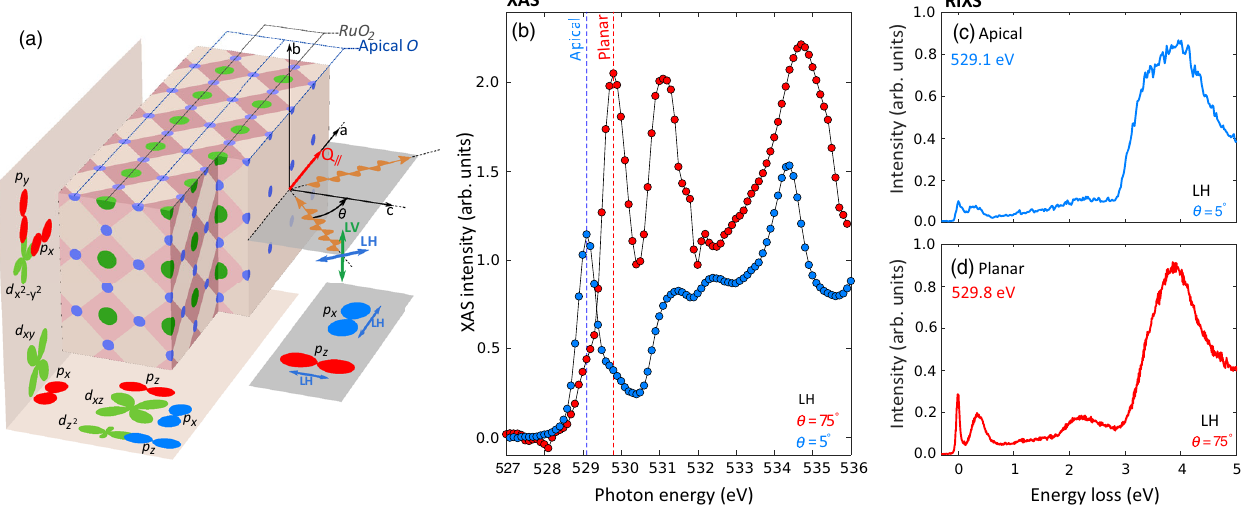
FIG. 1. (a) RIXS geometry with respect to the crystal lattice of Ca 2 RuO 4 is displayed schematically. Ruthenium and oxygen sites are shown with filled green and blue circles, respectively. The variable incident angle θ is defined with respect to the RuO 2 and apical oxygen planes. Using LVand LH polarized light, for different θ , sensitivity to either oxygen p oxygen orbitals in turn hybridize with different unoccupied t 2 recorded with linear horizontal light for near grazing and normal incident light conditions as indicated. (b) Background-subtracted x-ray absorption spectra recorded with settings that optimize either the apical or planar oxygen K -edge resonances as indicated by the dashed vertical lines. Panels (c) and (d) display RIXS spectra measured at the planar and apical oxygen K